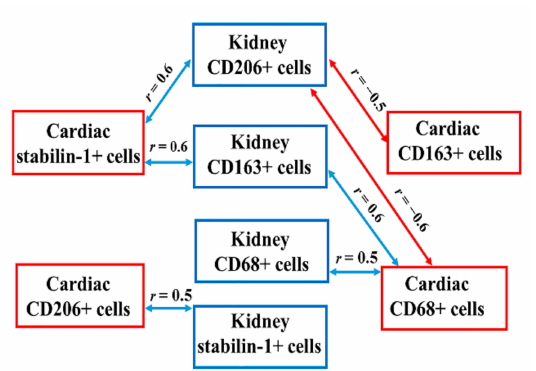
Figure 3. Correlations between kidney and cardiac macrophages in patients with fatal